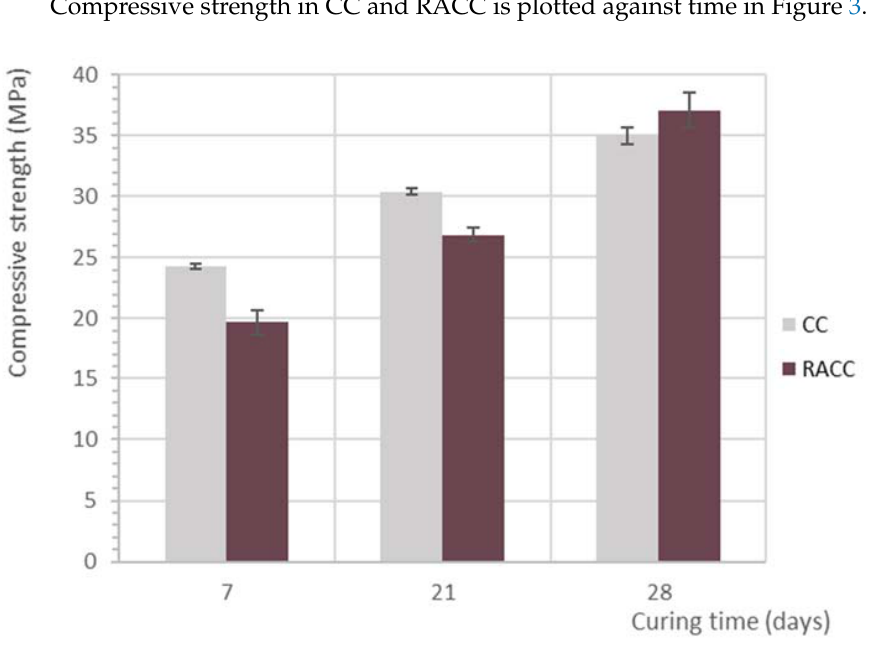
Figure 3. CC and RACC characteristic compressive strength by curing age